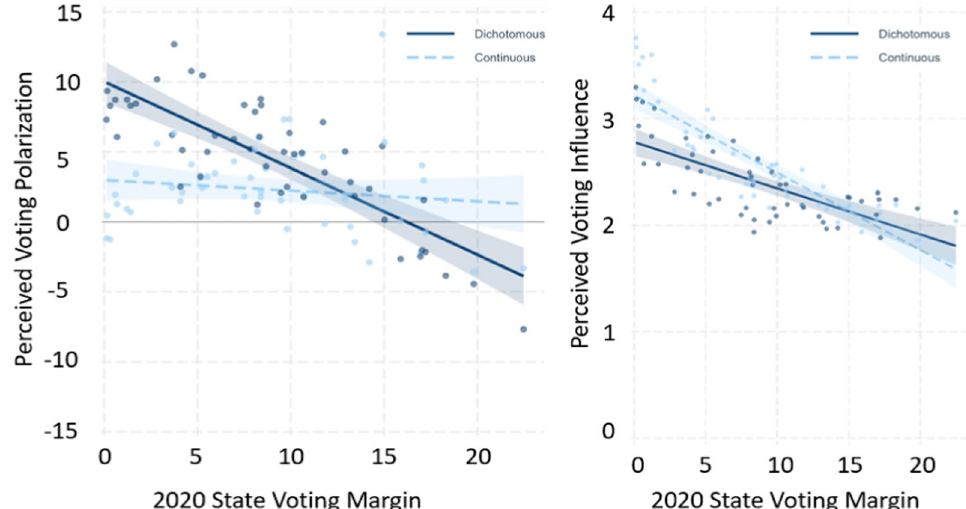
Fig. 7 The Plots depict the interaction between Gradient Steps (continuous versus dichotomous) and the true polarization of U.S. states in the 2020 presidential election, in predicting participants’ estimates of how polarized the states were (on the left plot) and participants’ perceived voting influence for each state/trial (on the right plot). Each State is represented twice, once as a dark dot for the average dichotomous voting margin and once as a light dot for the average continuous voting margin. Overall, the left plot demonstrates that dichotomous maps exacerbated the polarization of participants’ estimates except for a few extremely polarized states for which dichotomous colors led participants to underestimate polarization. The plot on the right demonstrates that perceived voting influence (measured on a 5-point Likert Scale) increased when continuous gradient steps were used as opposed to dichotomous gradient steps, but the effect is particularly strong in the states that had less (actual)